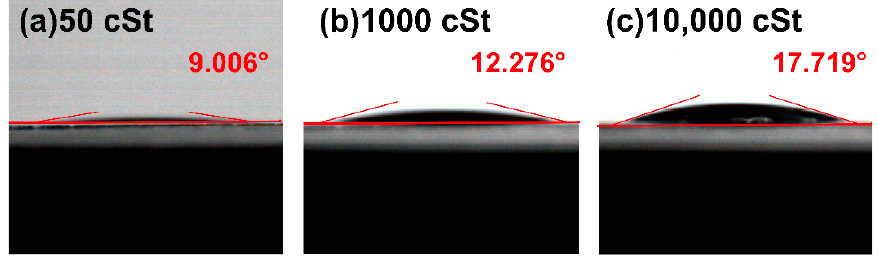
Figure 1. Contact angles between silicone oils with different viscosity and the V 40 Ti 26 Cr 26 Fe 8 alloy (s 1